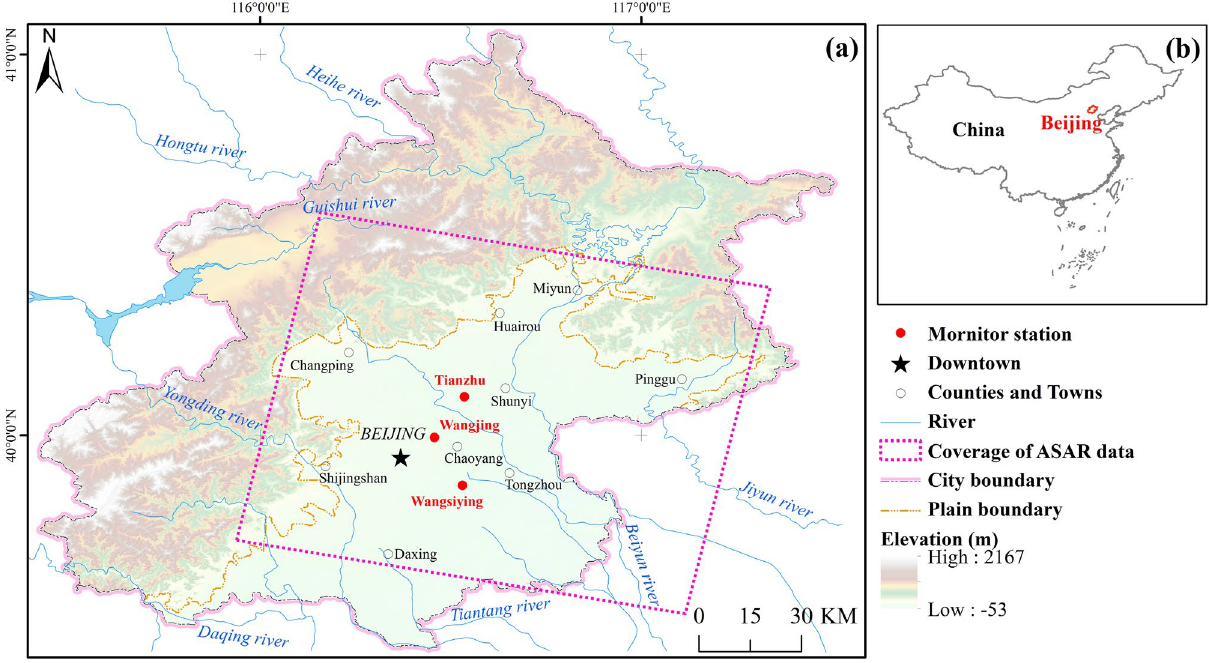
Figure 1. Location of the study area. ( a ) The pink dashed line shows the spatial coverage of Envisat ASAR data, which can cover most of the Beijing Plain area. The red dots represent the subsidence monitoring stations. ( b ) Location of Beijing. (Figure generated using ArcGIS v.10.6.0.8321, www. esri.